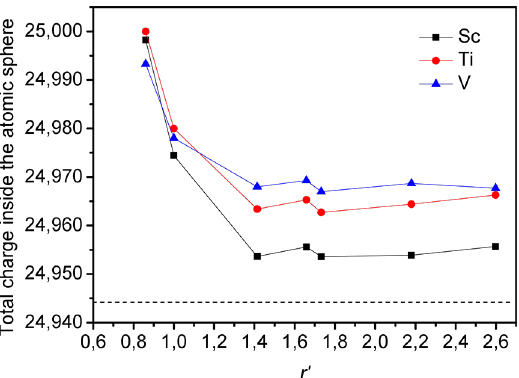
Figure 9. Total charge inside the atomic sphere of all iron atoms plotted as function of r’ . The dashed horizontal lines correspond to the total charge of iron in